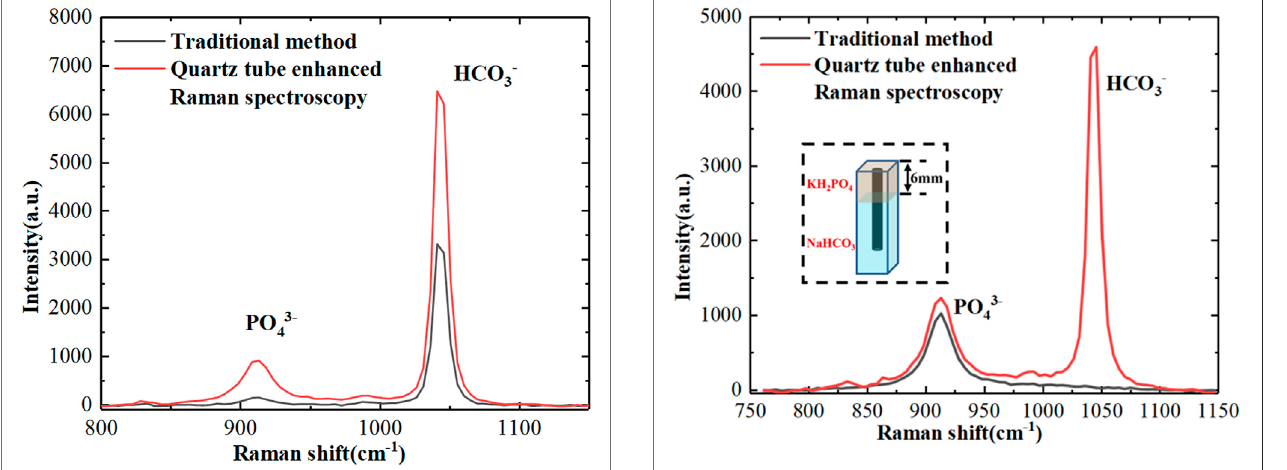
FIGURE 6 | Results comparison of quartz tube enhanced Raman spectroscopy and traditional Raman spectroscopy for mixed samples (1:5, m (PO 43- ):m (HCO 3 − )).